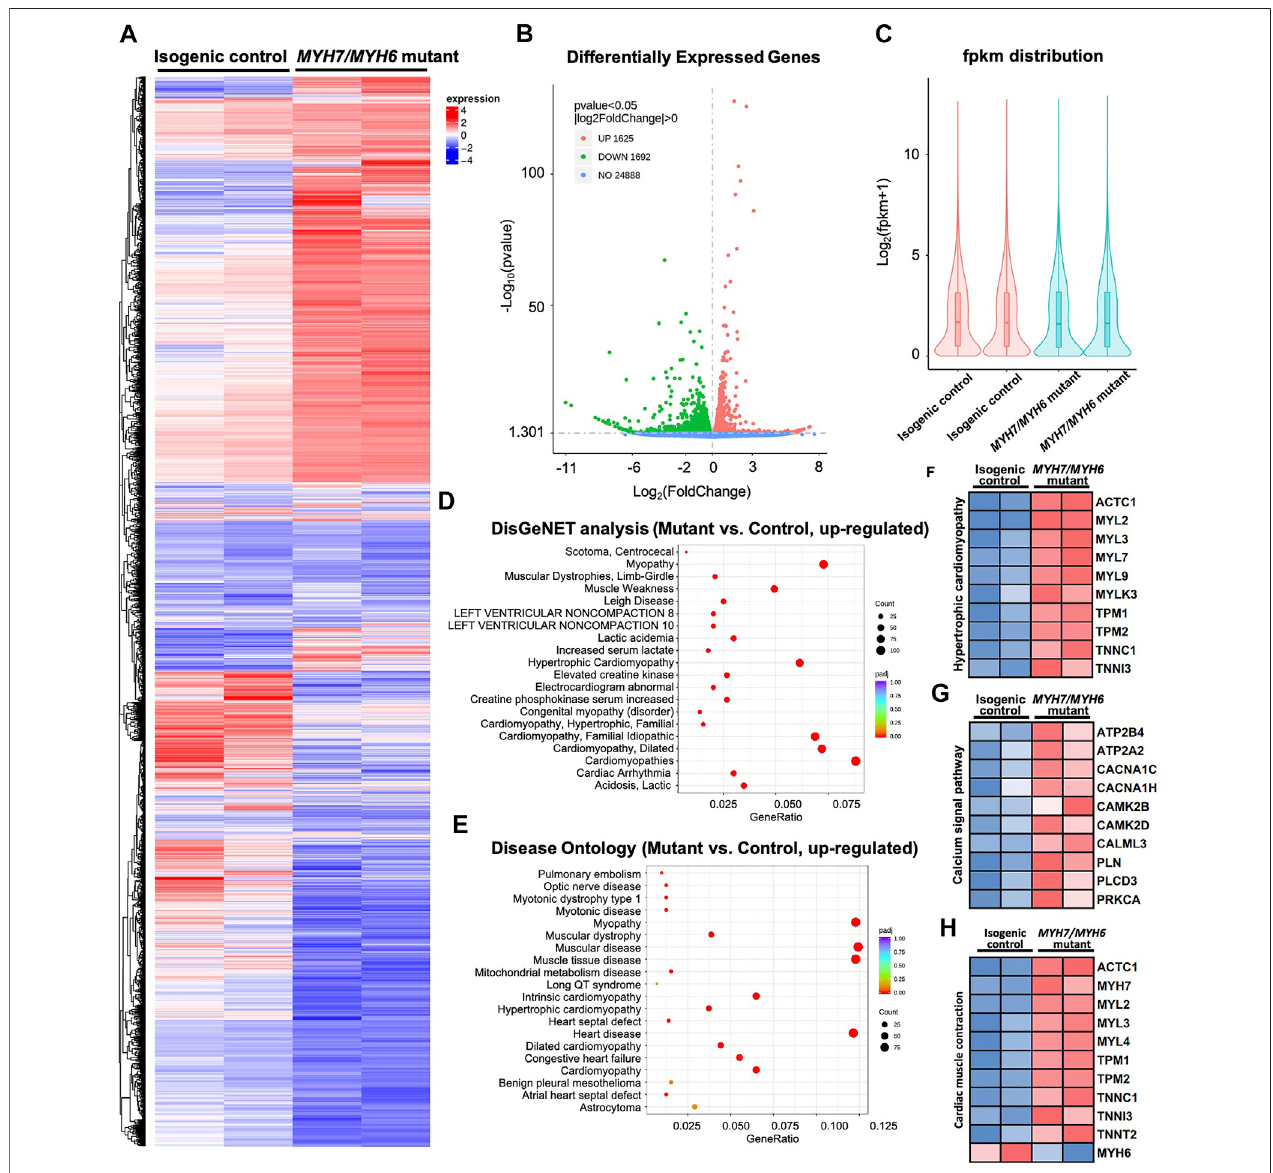
FIGURE 4 | Bulk RNAseq analysis of MYH7/MYH6 dual mutation-induced hypertrophic cardiomyopathy in Day 15 hiPSC-CMs to evaluate the molecular mechanism. (A) HeatmapforcomparingHCMmutantandcontrolhiPSC-CMsshowingthedysregulatedtranscriptsinthemutantcardiomyocytesrelativetocontrol. (B) Volcano plot showed a total of 3,317 differentially expressed genes (DEGs) with the mutation. ( p < 0.05, |log 2 fold change| > 0) (C) fpkm distribution showing similar log countsbetweenthecontrolandmutantlines. (D) Top20upregulatedgene-diseaseassociationsbyDisGeNetanalysis. (E) Top20upregulateddiseasesannotated bydiseaseontology(DO)analysis.Sizeofthedotindicatethenumberofgeneassociatedwiththegivendiseaseandredcolorindicatethesigni fi canceofthisassociation. (F) Heatmap for 10 up-regulated DEGs that associated with hypertrophic cardiomyopathy. (G) Heatmap for 10 up-regulated DEGs that associated with calcium signal pathway. (H) Heatmap for 10 up-regulated DEGs and 1 downregulated DEG associated with cardiac muscle contraction.